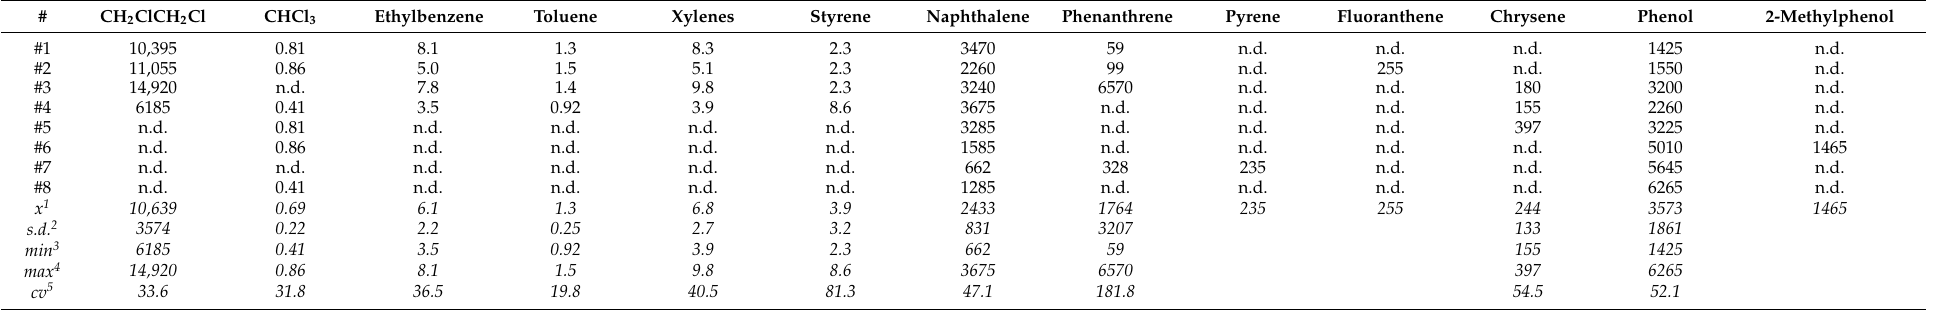
Table 3. Content of organic compounds ( µ g kg − 1 ; n.d., not detected) determined by means of GC-IT/MS in the different samples investigated. For sample identification, see Table